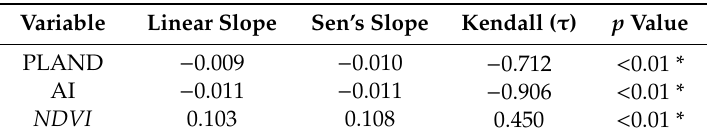
Table 2. Temporal trend patterns of indices of the urban greenness landscapes and normalized di ff erence vegetation index ( NDVI ).